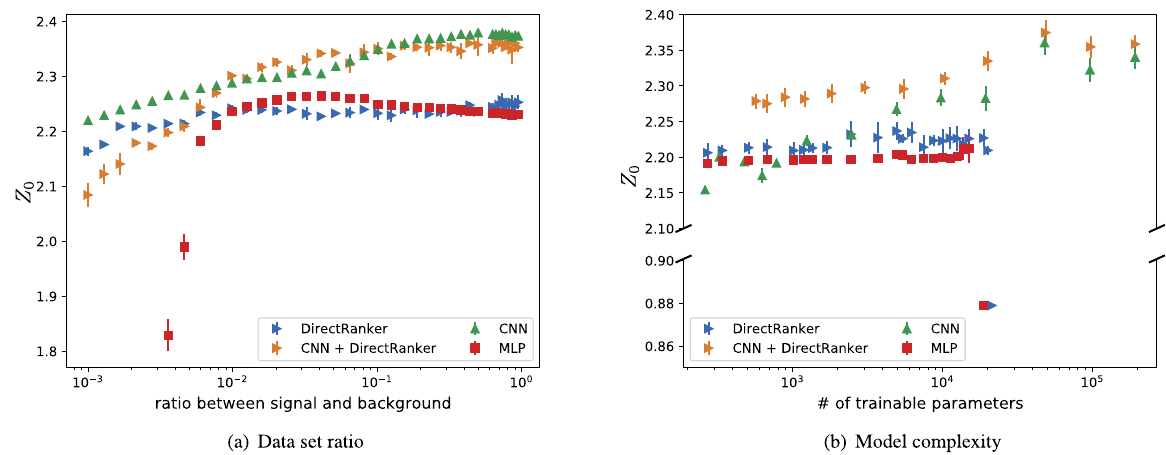
Figure 1. Performance of different machine learning models evaluated using the Z 0 metric in a fivefold cross- validation. In ( a ), the models are trained on different signal and background ratios and tested on an equal number of signal and background events. An overview of the generated data set can be found in Table 2 in the experimental setup. In ( b ), the model complexity is increased while using the balanced data set for training and testing. We tested a convolutional neural network (CNN), a multilayer perceptron (MLP), the DirectRanker, and its combination with convolutional layers (CNN + DirectRanker).